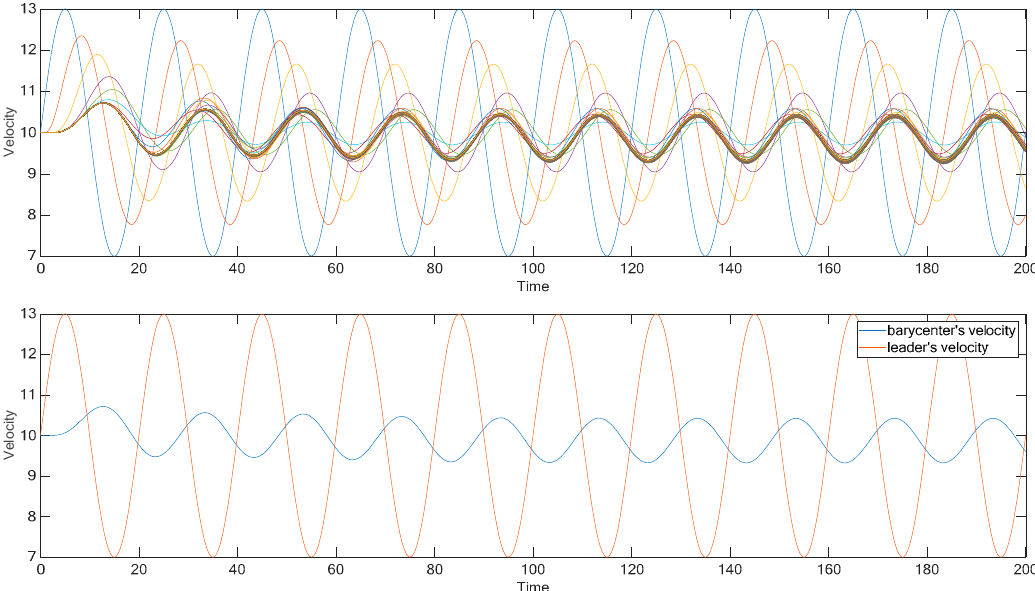
Figure 11. The small-world model simulated with 500 vehicles and with p = 0.05, excited by the harmonic perturbation of the Leader’s velocity Equation (14). On ( top ), the velocity of each vehicle that follows the leader, on the ( bottom ), the velocity of the leader and the one of the barycenter of the system of 500 vehicles, plotted versus time.